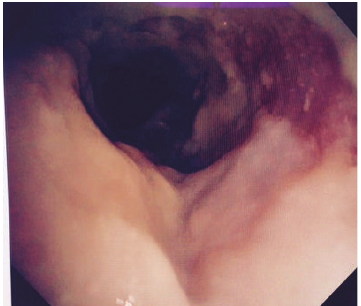
Figure 1: CT of chest without contrast displaying bilateral lower lobes, right greater than left.